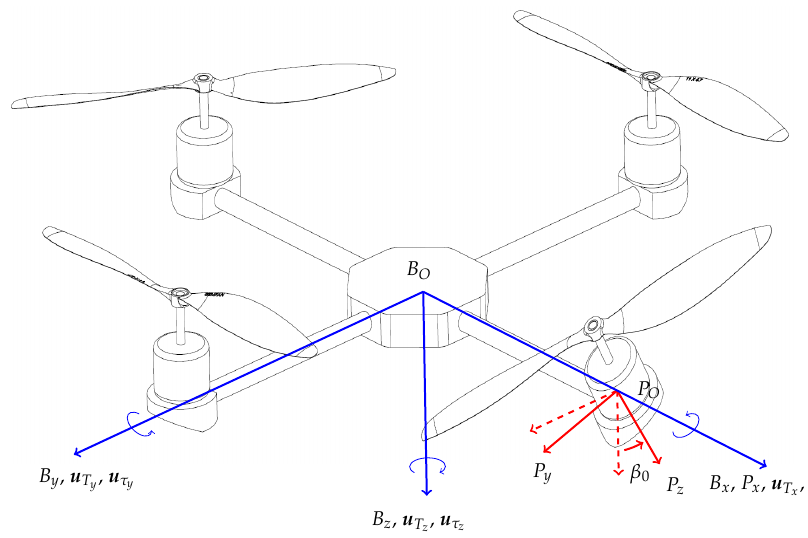
Figure 1. A schematic of the proposed single tilt-rotor multirotor helicopter. Figure 1. The proposed single tilt-rotor multirotor